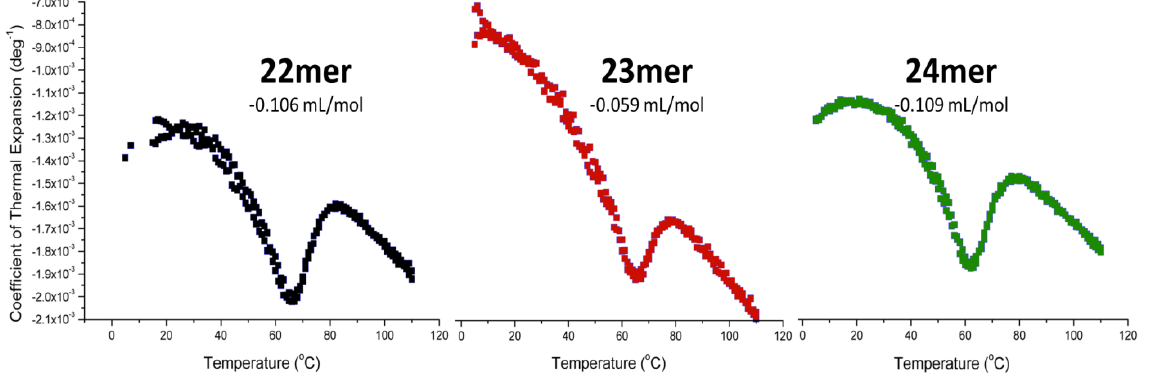
− 0.106 mL/mol, the 5'-T (23-mer) was − 0.059 mL/mol, and the (5'-TT) 24-mer was − 0. 109